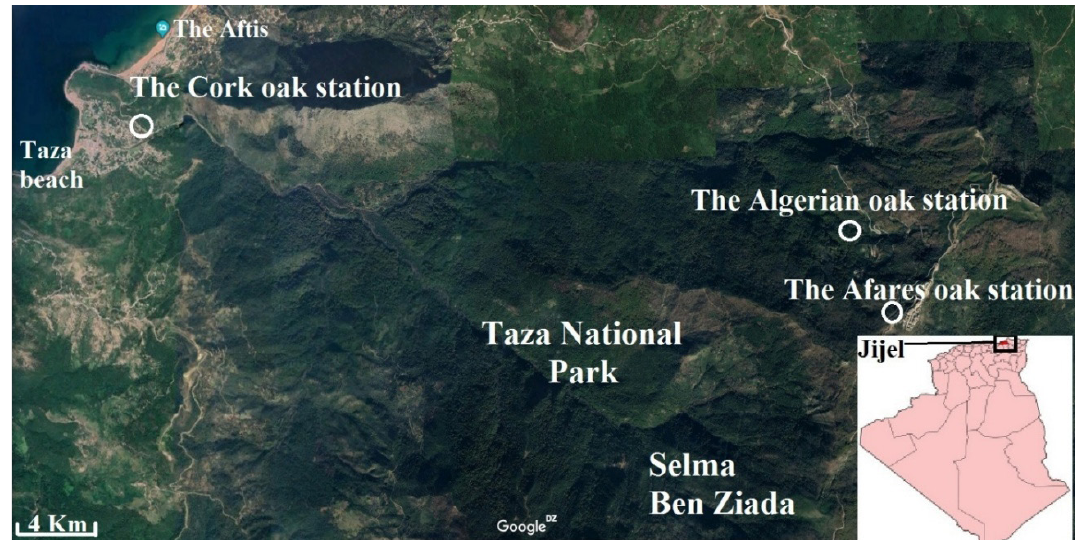
Fig 1 . The three study stations location in Taza National Park